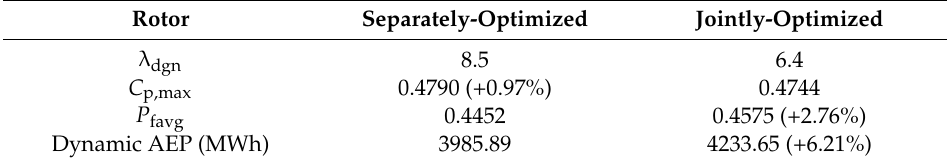
Table 5. Comparison results of the static and closed-loop performance between different rotors. Rotor Separately-Optimized Jointly-Optimized